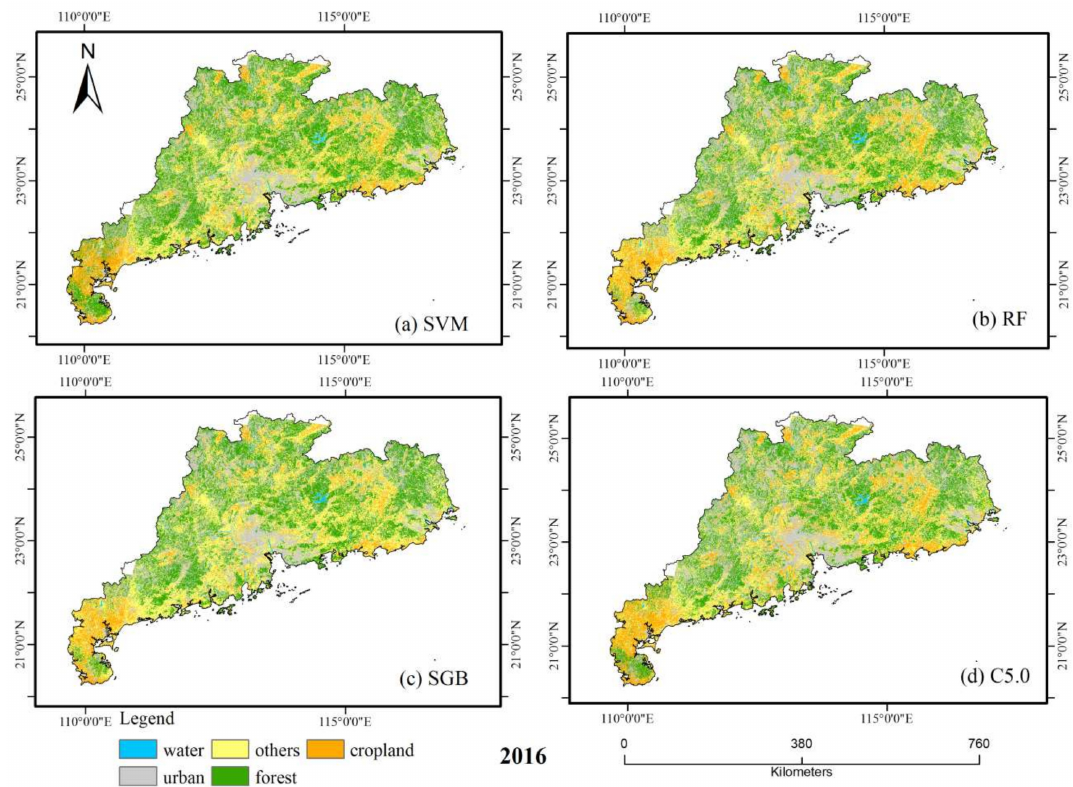
Figure 8. The 2016 land cover classifications based on SVM (a), RF (b), SGB (c), and C5.0 (d) in the Guangdong province of